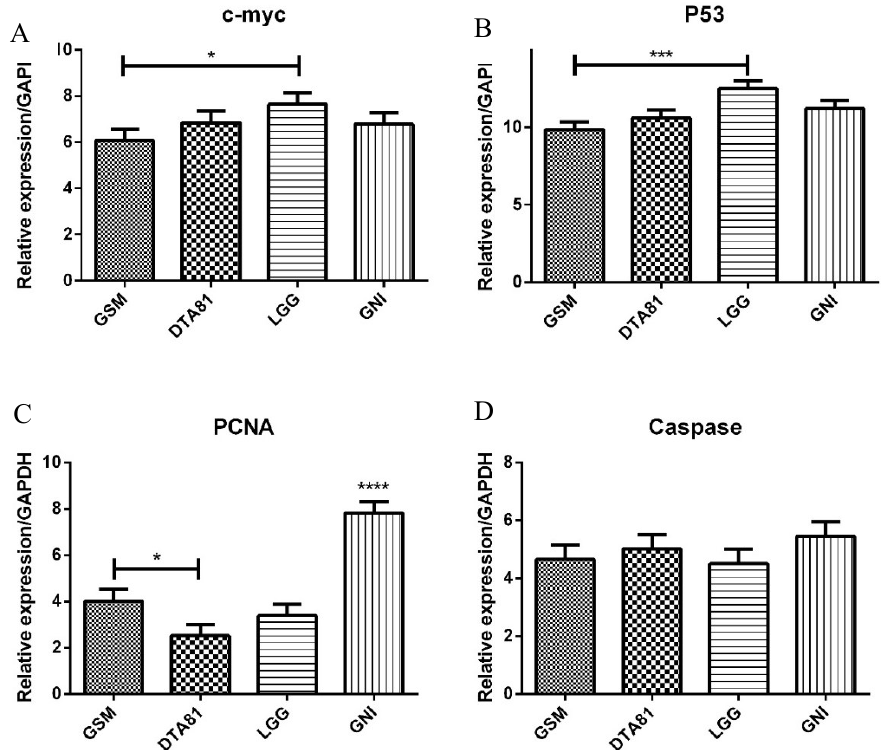
Figure 5. Gene expression assessment by quantitative real-time polymerase chain reaction (RT-qPCR) of four tumor-related genes associated with CRC development. ( A ) c-myc ; ( B ) p53 ; ( C ) PCNA; ( D ) Caspase-3. Values are means ± SEM ( n = 6). *, p ≤ 0.05; ***, p ≤ 0.001; ****, p ≤ 0.0001.